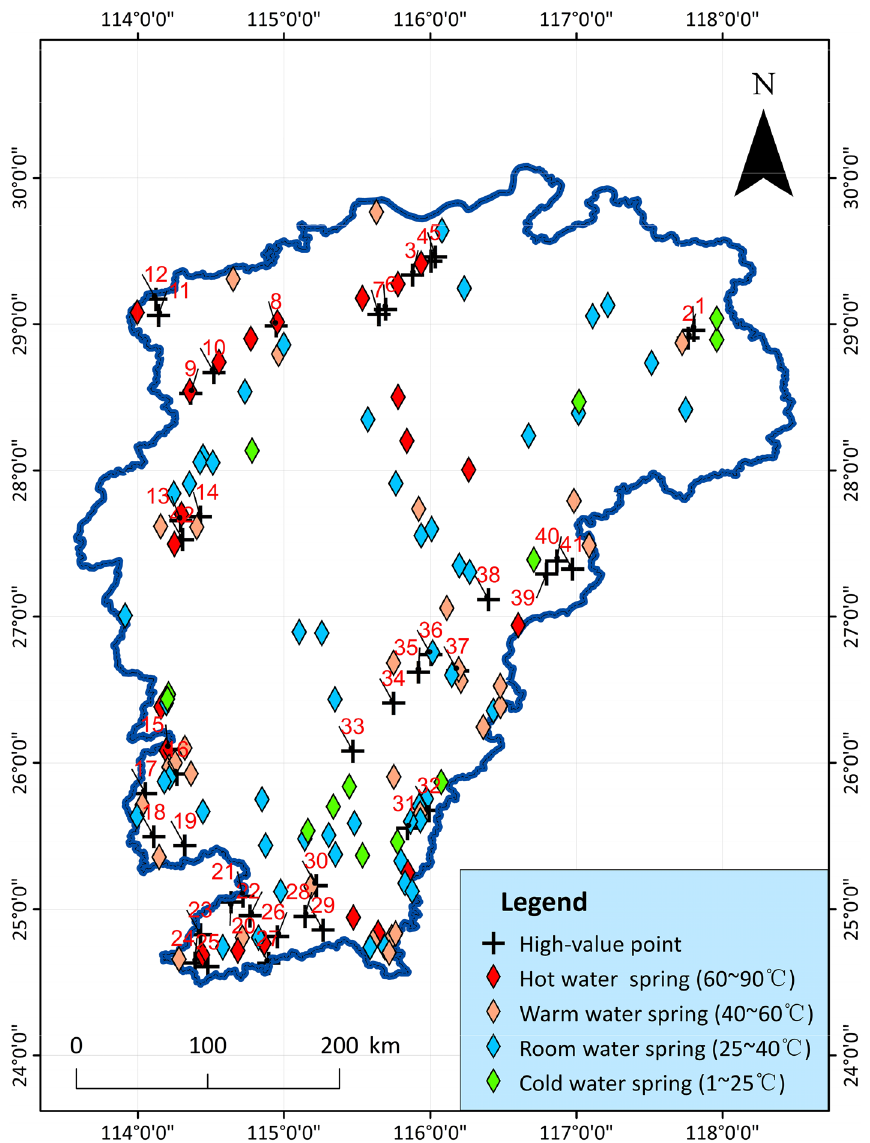
Figure 18. Verification and comparison of geothermal high-value points, showing the location of existing and presumed